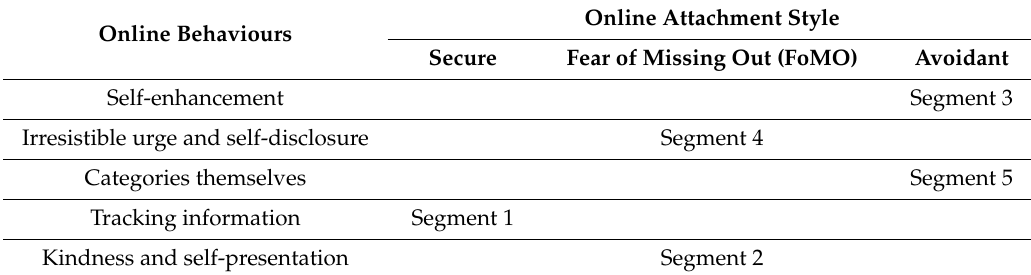
Table 1. The segmentation process for users with problematic online